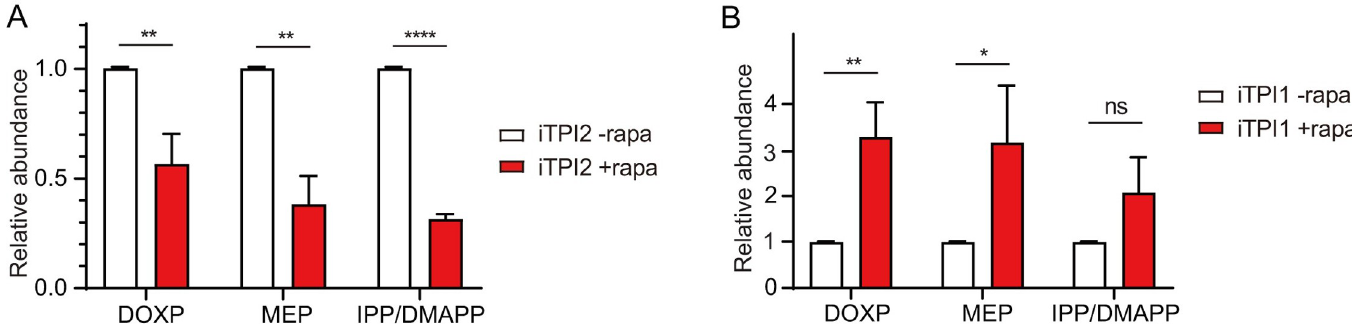
Fig 5. TPI2 depletion reduces isoprenoid precursors synthesis through the MEP pathway. Relative abundance of DOXP, MEP and IPP/DMAPP in the iTPI2 (A) and iTPI1 (B) strains cultured in the presence (+rapa) or absence (-rapa) of rapamycin, as determined by mass spectrometry.